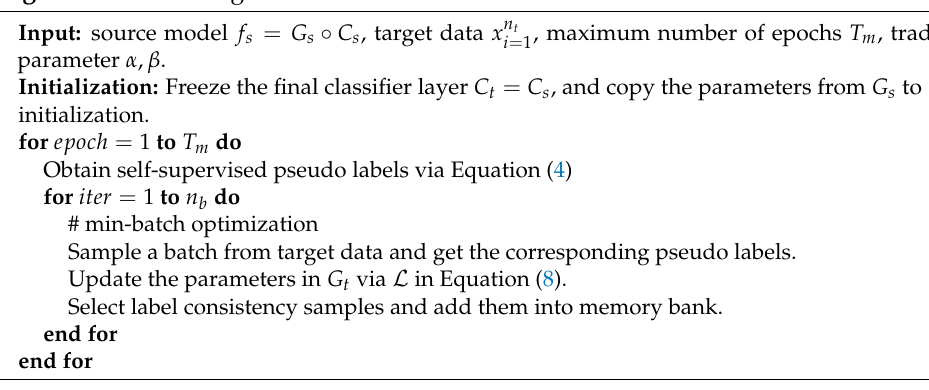
Algorithm 1 LCCL algorithm for SFUDA